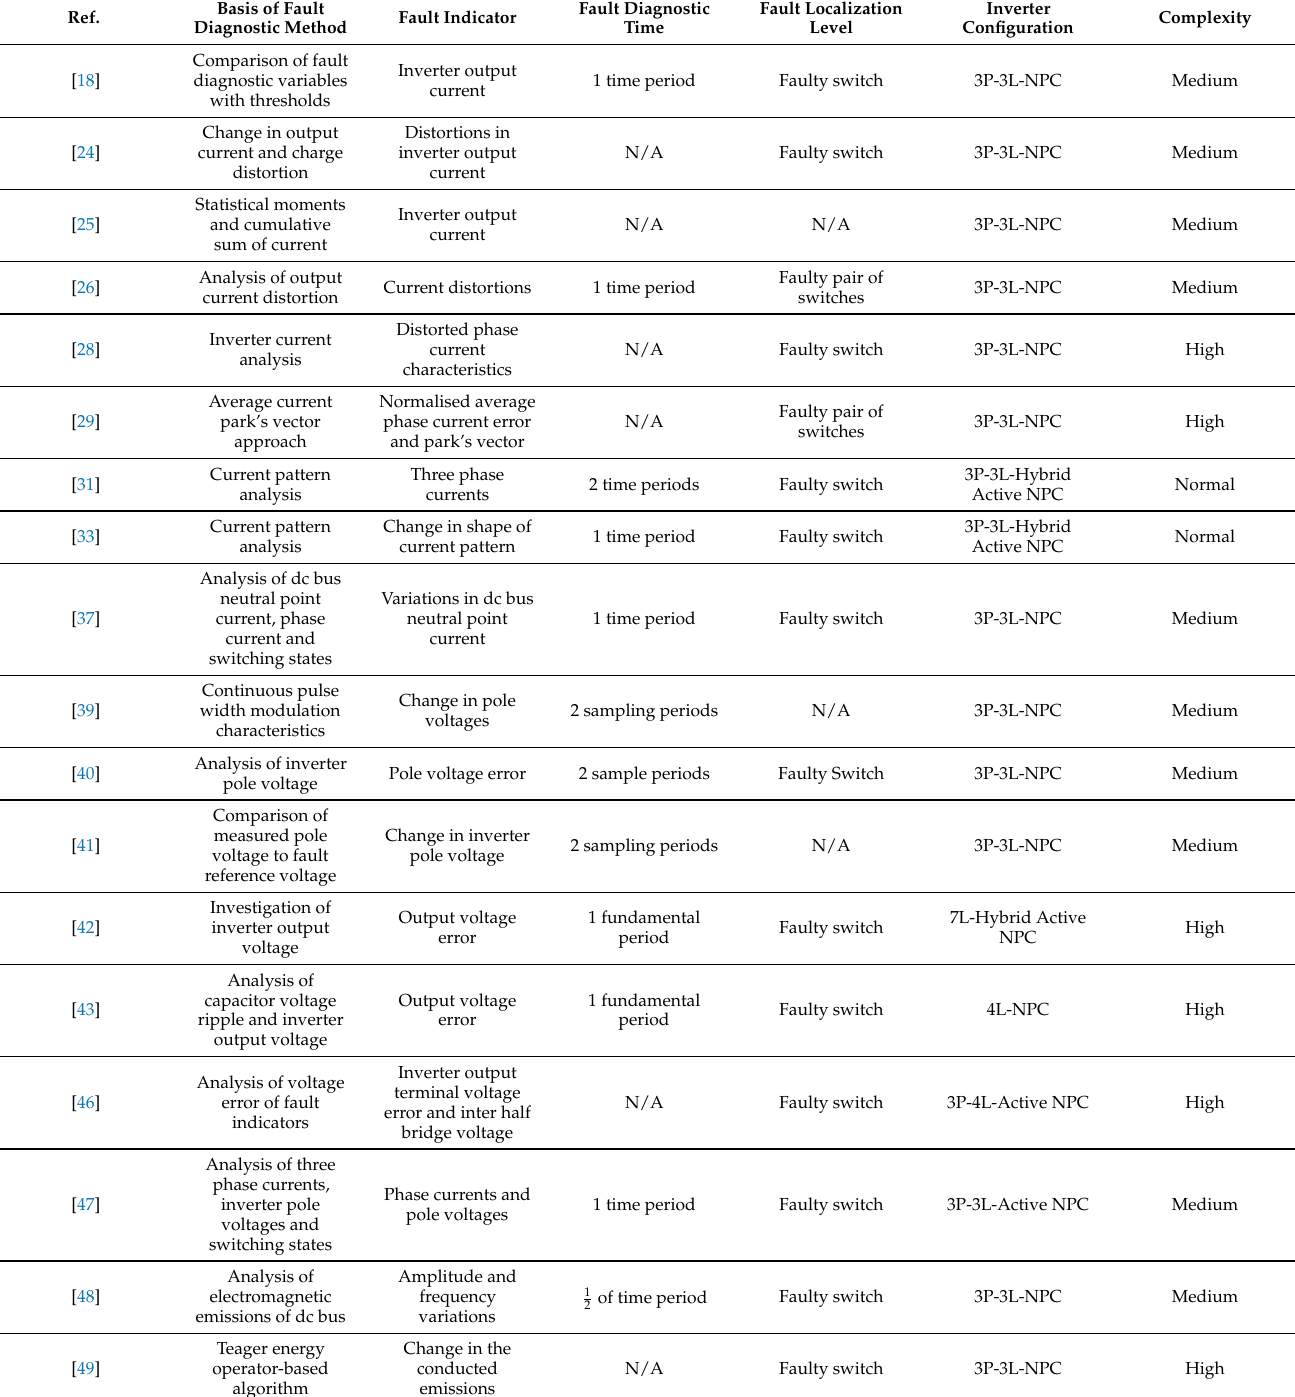
Table 3. Signal processing based fault diagnostic Methods.